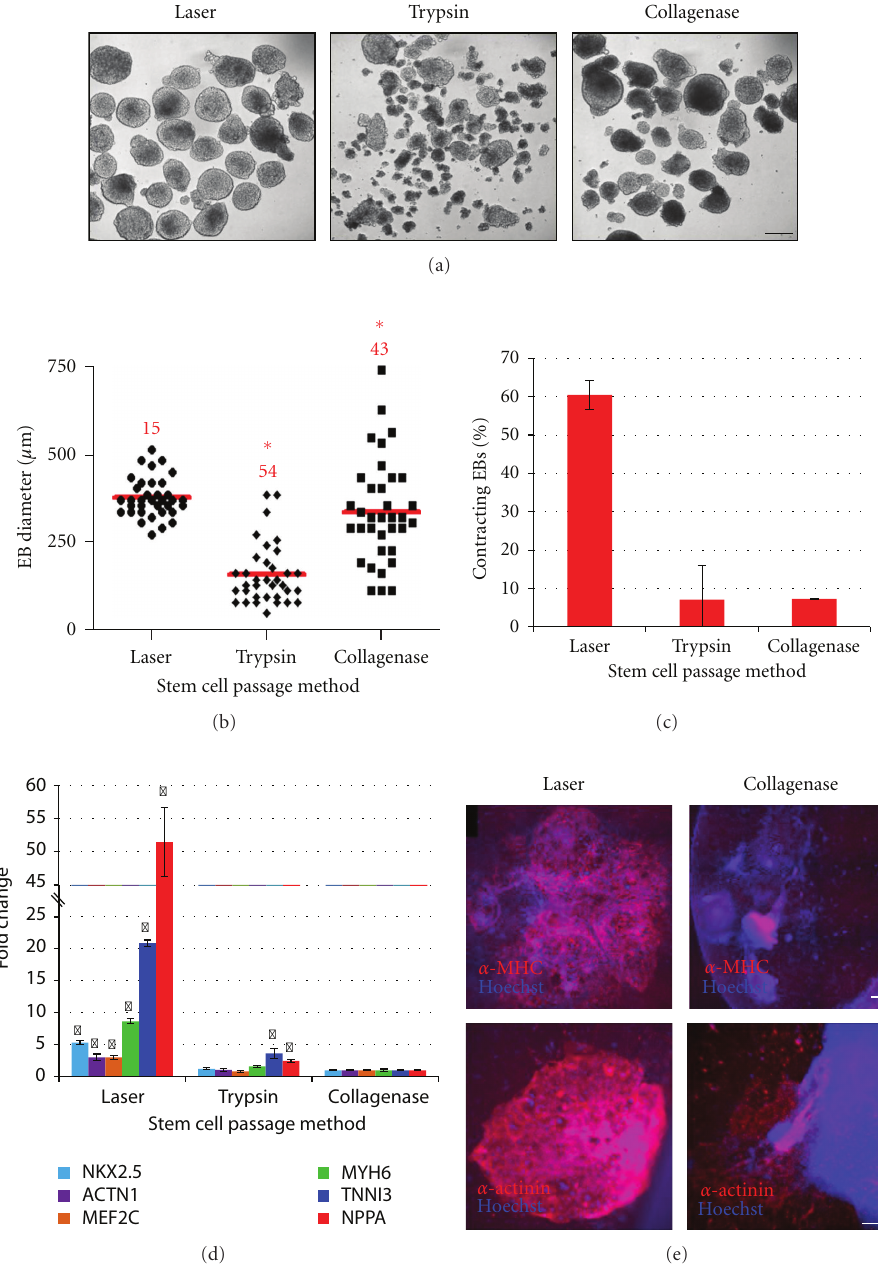
Figure 5: iPSCs propagated by laser-mediated passage di ff erentiated more e ffi ciently into cardiomyocytes. (a) Brightfield image of day 4 EBs generated from iPSC cultures (BIMR A) propagated by laser-mediated passage, trypsin dissociation, or collagenase treatment. Scale bar, 250 μ m. (b) Size of EBs generated from iPSC cultures propagated by laser-mediated passage, trypsin dissociation, or collagenase treatment ( n = 35 EBs per data point). Data are shown as scatter plot with red line indicating mean and CV shown in red text above each sample. The asterisks ( ∗ ) indicate variances that are statistically significant when compared to laser using ANOVA, with P ≤ 0 . 05 considered significant. (c) Percentage of EBs containing contracting areas. Data are shown as mean + s.d. ( n = 2 independent experiments containing 75 EBs/sample in each experiment). (d) QRT-PCR analysis of cardiomyocyte-associated gene expression in EBs generated using iPSC cultures propagated by laser-mediated passage, trypsin dissociation, or collagenase treatment. The asterisks ( ∗ ) indicate values that are statistically significant as compared with EBs generated from collagenase passaged iPSC cultures. The data are presented as mean ± s.d. ( n = 3). Statistical analysis was performed using t -test with P ≤ 0 . 05 considered significant. (e) Expression of cardiomyocyte markers, α -MHC and α -actinin, in EBs generated from iPSC cultures propagated by laser-mediated passage or collagenase treatment on day 22 of cardiac di ff erentiation. Hoechst was used as a nuclear counterstain. Scale bars, 250 μ